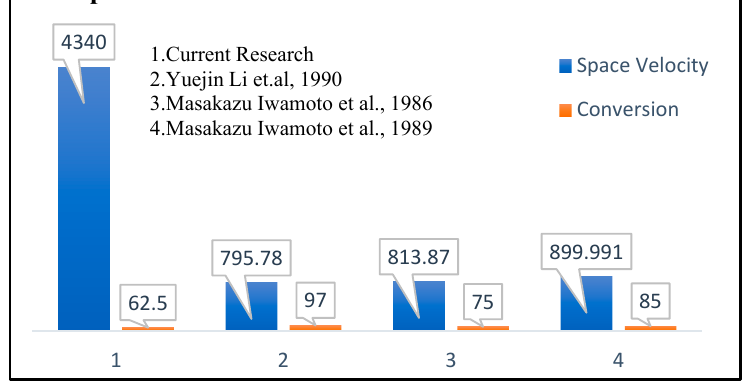
Figure 15. Comparison of space velocity and NO conversion [53–55].